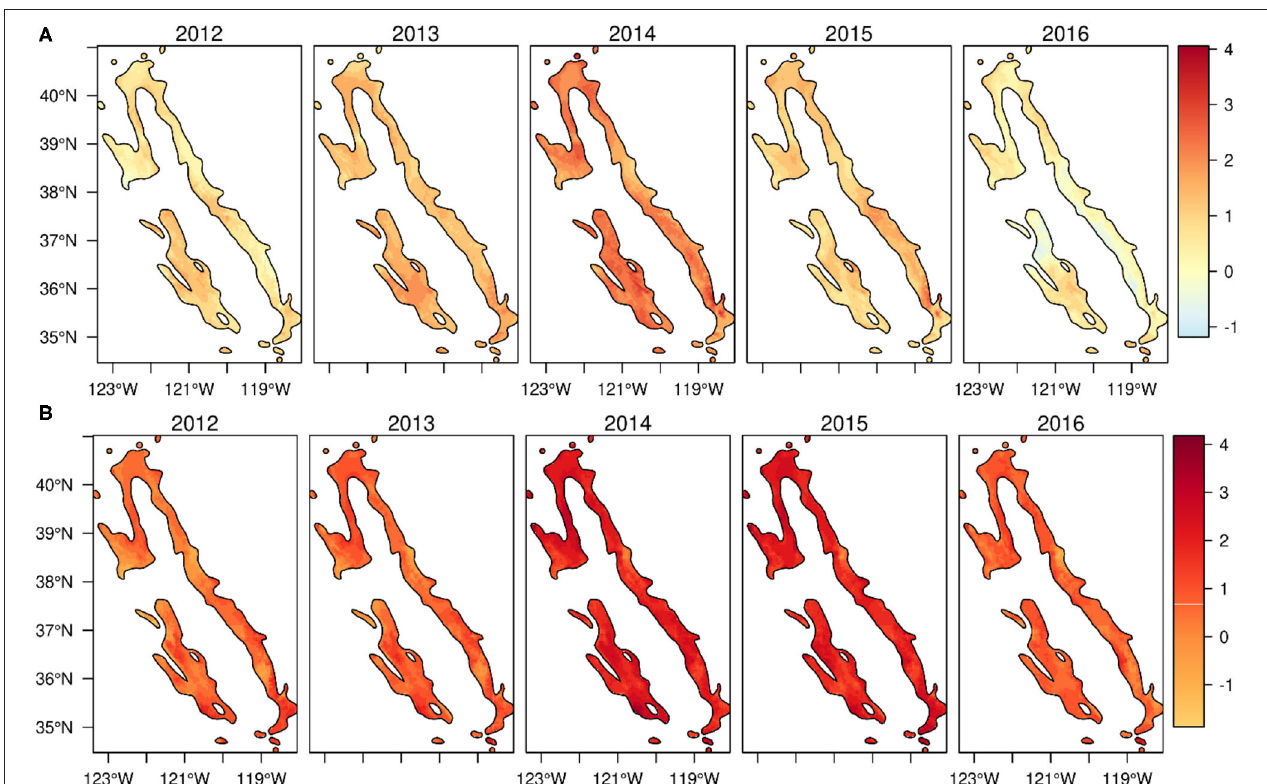
FIGURE 4 | Time series maps showing the spatial pattern of standardized anomaly (z-score) of (A) climatic water deficit (PRISM 800-m resolution) and (B) maximum temperature (PRISM 4-km resolution) across blue oak woodlands of California during 2012 and